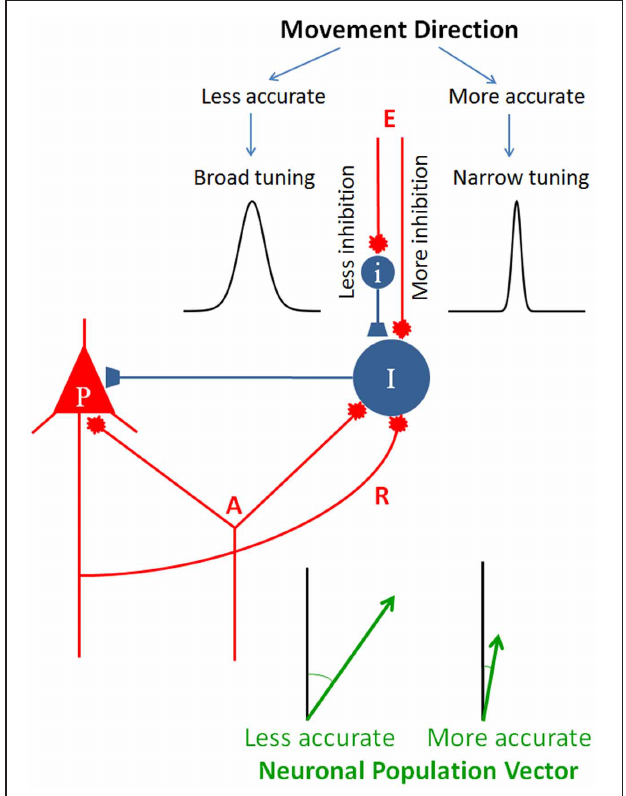
FIGURE 5 | Schematic diagram to illustrate the hypothesis of directional accuracy via a variably tuned circuit. Red and blue terminals indicate excitatory and inhibitory synapses, respectively. P, pyramidal cell; I and i, inhibitory interneurons; A, afferents impinging on both the pyramidal cell and inhibitory interneuron; R, recurrent collateral. The two tuning curves were chosen from those shown in Figure 1 to illustrate two different tuning widths. The lengths of the two population vectors differ to illustrate the speed-accuracy tradeoff (see text for details).